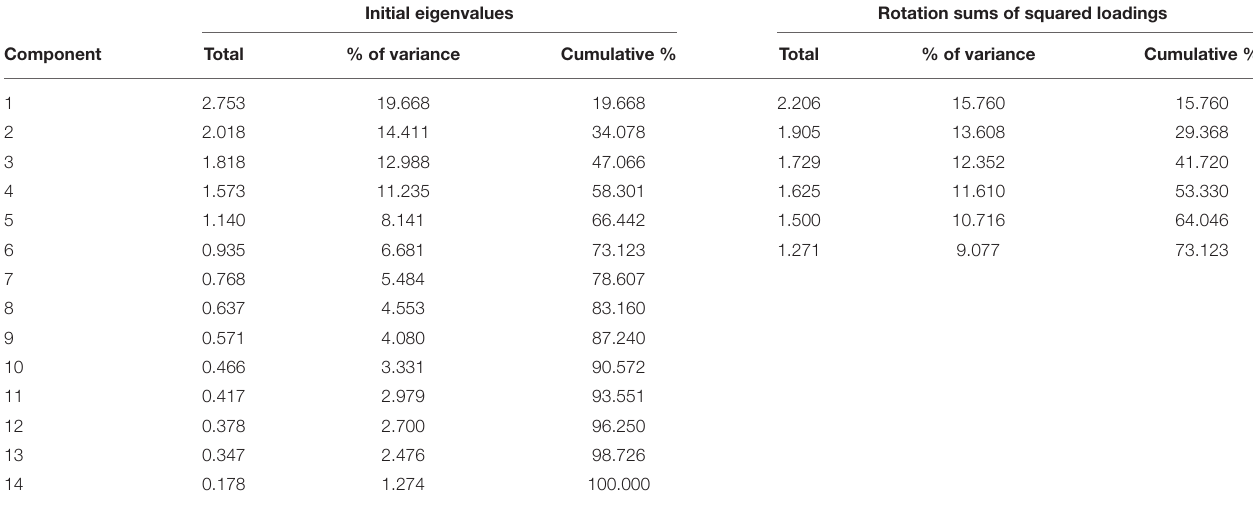
TABLE 3 | Total variance explained.